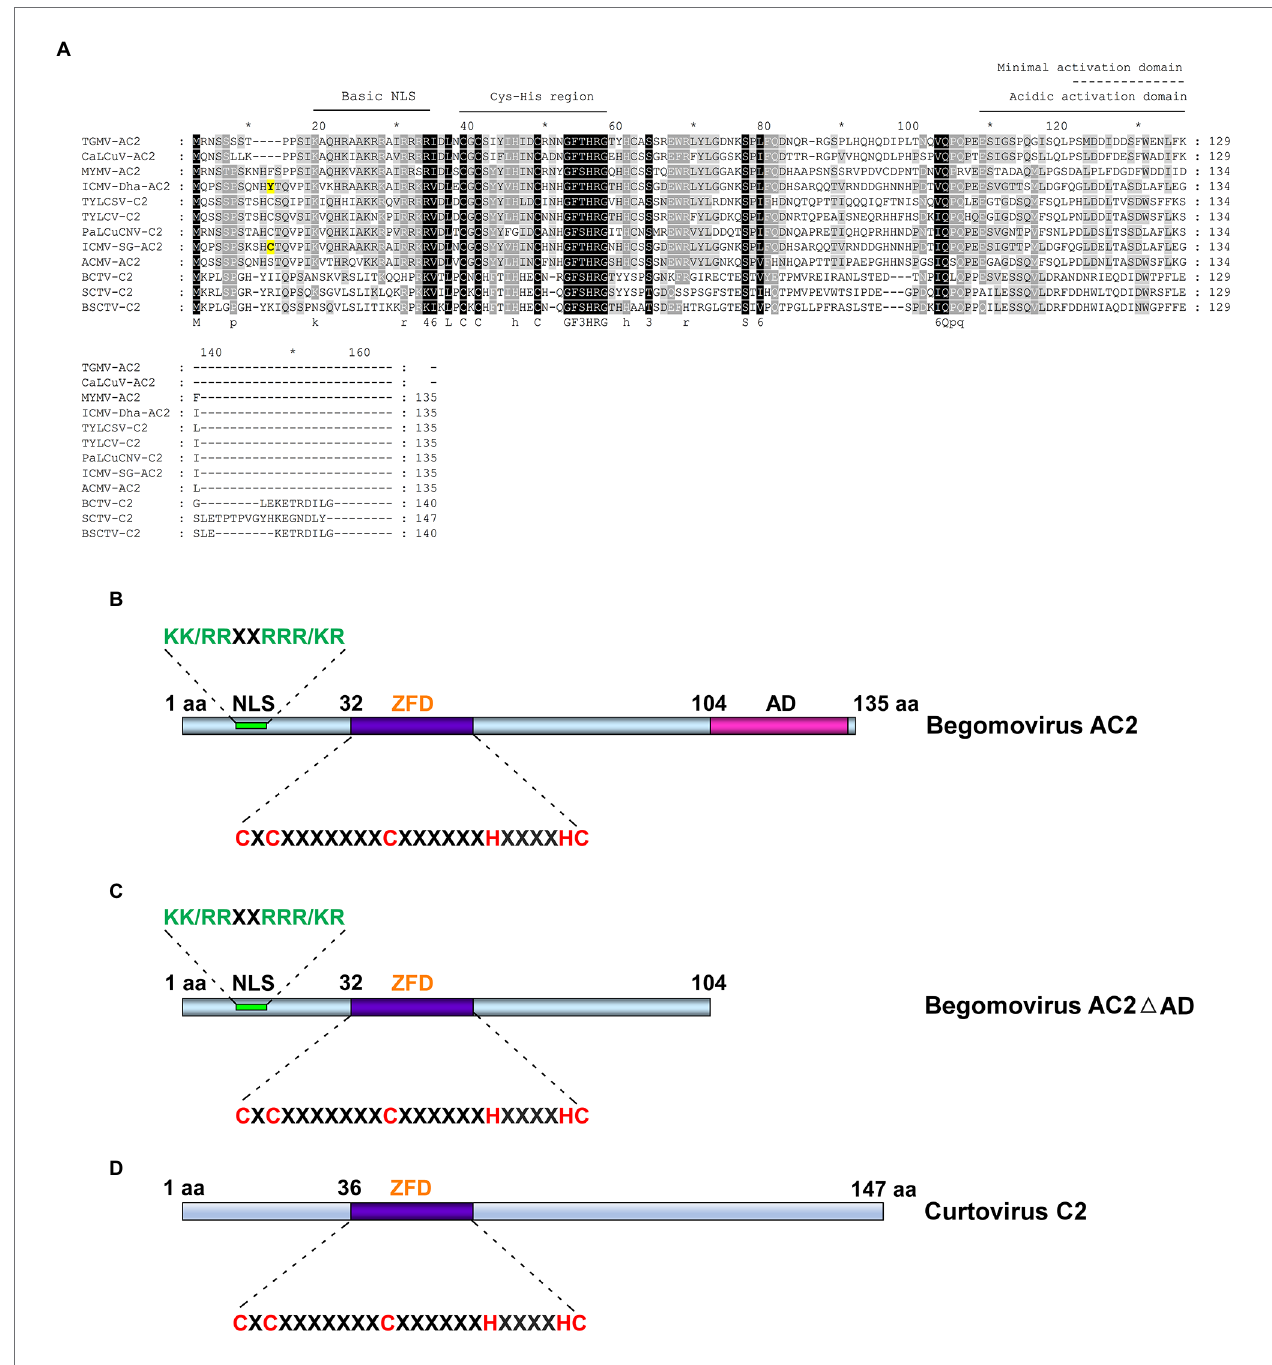
FIGURE 2 | Alignment of AC2 of bipartite, C2 proteins of monopartite begomovirus, and C2 of curtovirus. (A) Clustal alignment of AC2/C2 amino sequences of Tomato golden mosaic virus (TGMV; acc. no. NC_001507); Mungbean yellow mosaic virus (MYMV; acc. no. AJ132575); African cassava mosaic virus (ACMV; acc. no. NC_001467); Indian cassava mosaic virus -Singapore (ICMV-SG; acc. no. JX518289); Indian cassava mosaic virus -Dharwad (ICMV-Dha; acc. no. GQ924760); Cabbage leaf curl virus (CaLCuV; acc. no. NC_00386); Tomato yellow leaf curl Sardinia virus (TYLCSV; acc. no. L27708); Tomato yellow leaf curl virus (TYLCV; acc. no. AM282874); Papaya leaf curl China virus (PaLCuCNV; acc. no. FN256260); Beet curly top virus (BCTV; acc. no. AF379637); Beet severe curly top virus (BSCTV; acc. no. U02311); and Spinach curly top virus (SCTV; Acc. No. AY548948). The conserved N-terminal basic domain, the Cys-His residues in the middle and the C-terminal acidic activation domain are marked. The Tyr residue in ICMV-Dha strain and Cys residue in pathogenic ICMV-SG strain are highlighted in yellow. (B) Schematic representation of begomovirus AC2 involved in activation domain-dependent silencing suppression. (C) Schematic representation of begomovirus AC2 with deletion in activation domain (AC2 Δ AD) involved in activation domain-independent silencing suppression. (D) Schematic representation of curtovirus C2 involved in activation domain-independent silencing suppression. NLS, nuclear localization signal; ZFD, zinc-finger like domain; and AD, activation